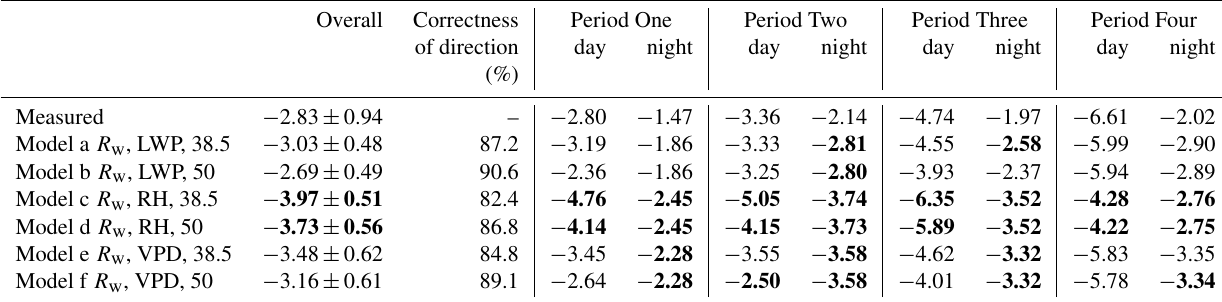
Table 1. Summary of model results, with comparison to measured hourly NH 3 fluxes (in ngm − 2 s − 1 ). Presented are the overall mean average flux for measured and modelled NH 3 fluxes (with associated errors), the correctness of modelled flux direction in comparison to the measured values, and mean average values for modelled and measured NH 3 fluxes during day (06:00–17:00) and night (18:00–05:00) for the four periods of the measurement campaign. Values in bold signify average model values which differ by ± 25% from corresponding measured average